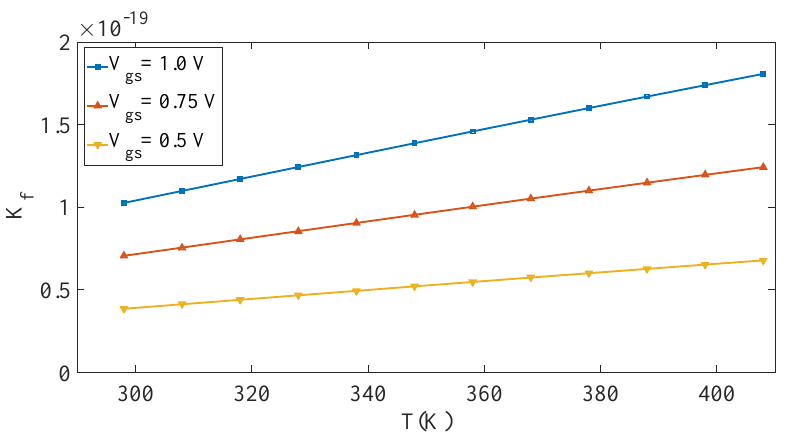
Figure 9. Hold generation constant for the InGaAs − − Al 2 O 3 interface for varying temperatures ( T ). Table 2. Extracted BTI model parameters for InGaAs − − Al 2 O 3